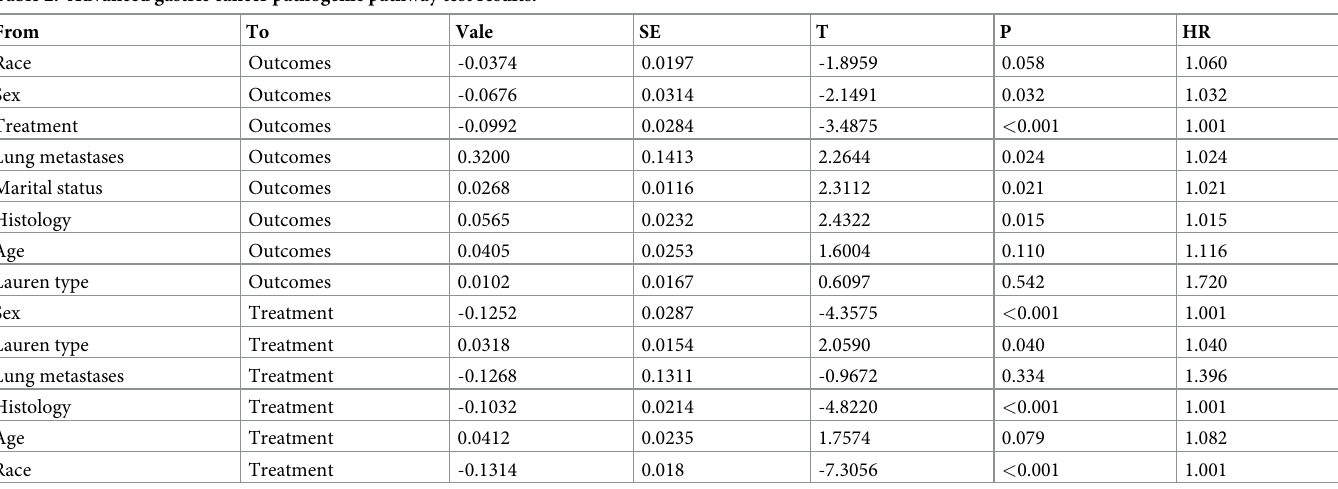
Table 2. Advanced gastric cancer pathogenic pathway test